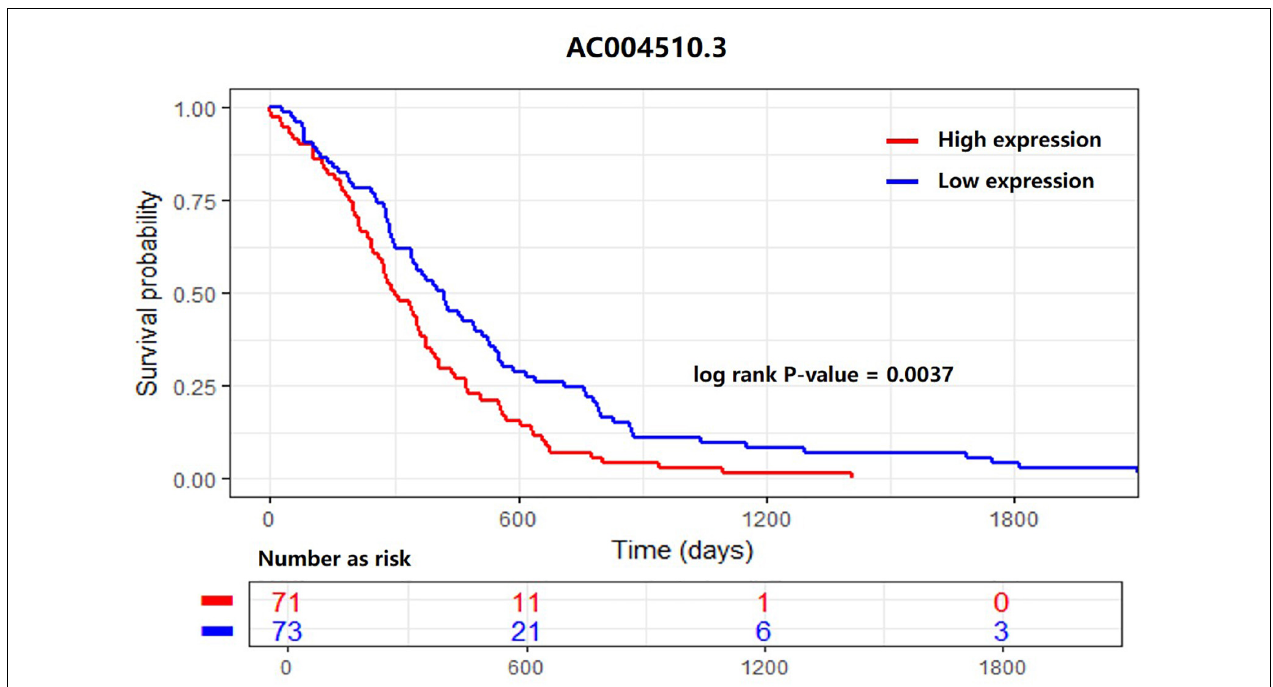
FIGURE 5 | Kaplan–Meier survival analysis for the lncRNA AC004510.3, which is an intergenic lncRNA and is highly expressed in gastric cancer tissues. The lncRNA could significantly distinguish 170 patients into two groups with different 5-year survival statuses. The expression level was significantly correlated with the survival time of gastric cancer patients ( P -value =